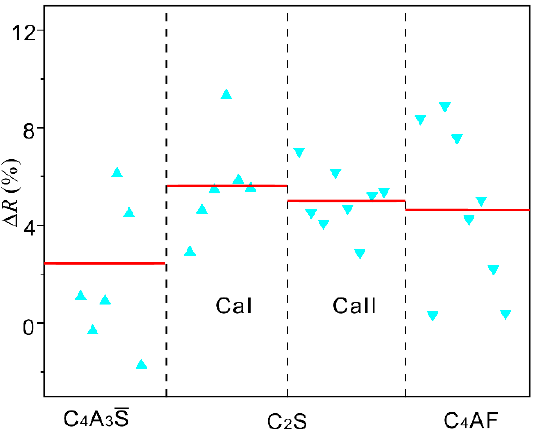
Figure 7. The relative bond length ( ∆ R ) of C 4 A 3 S, C 2 S, and C 4 AF with Pb ions introduced at Ca sites. The red lines represent the averaged values of ∆ R. The regular and the inverted triangles represent the 6- and 8- fold Ca, respectively.